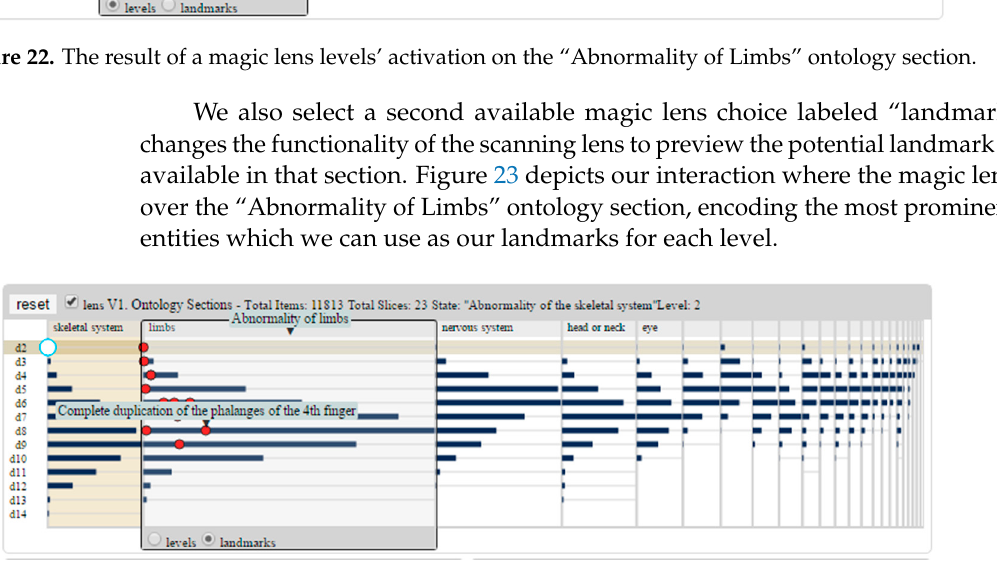
Figure 23. The result of a magic lens on the “Abnormality of Limbs” ontology section.